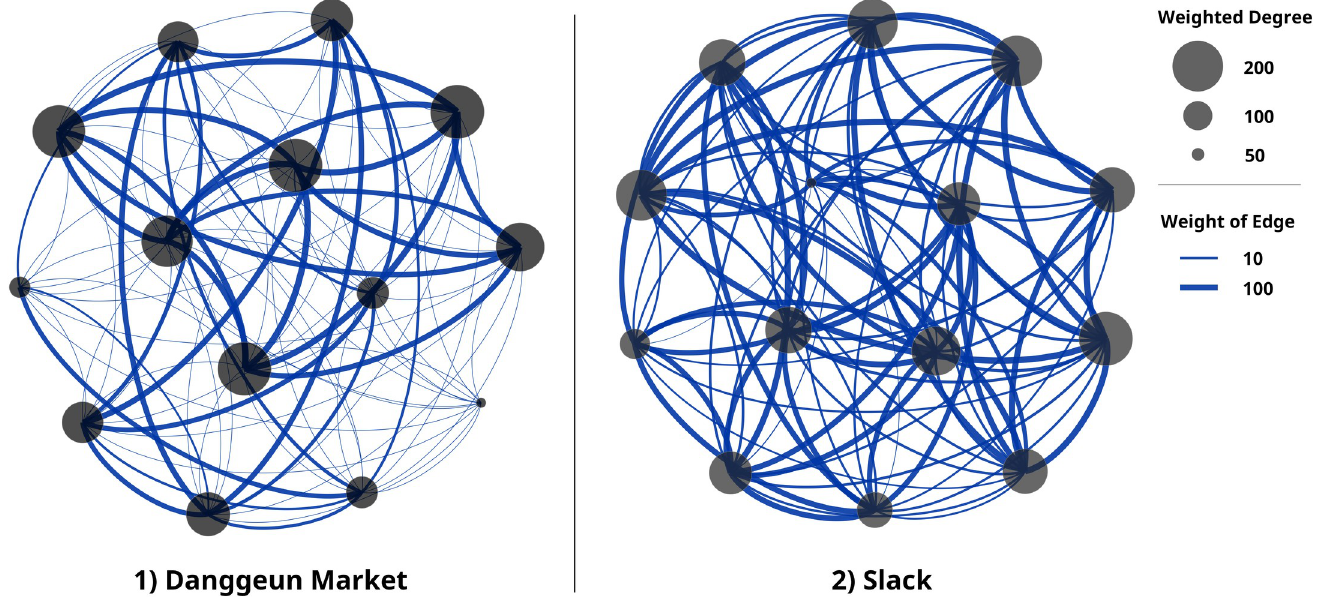
Fig 7. Augmented-proximity (AP)-based network visualization that reflects weight according to AP characteristics based on two services.